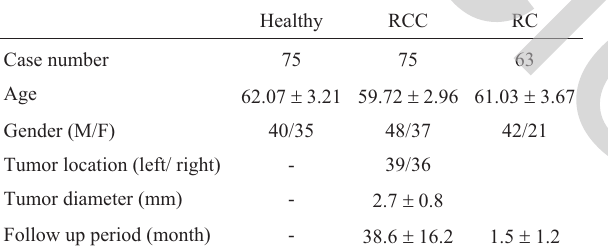
Table 1 - Demographic data of selected